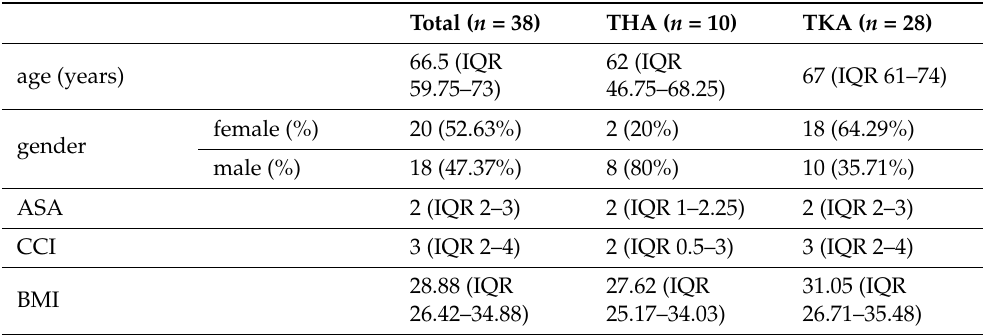
Table 1. Demographic characteristics of the study